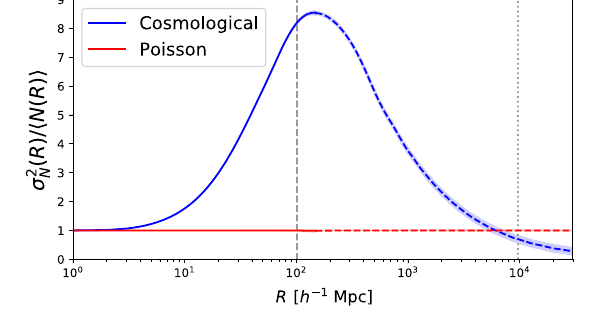
FIG. 4. Local number variance for the cosmological (blue) and Poisson (red) simulations as a function of scale R . This is defined as the variance of the number of particles found in spheres of radius R and computed directly from the correlation function shown in Fig. 3. The dashed lines show an extrapolation to large R , using the theoretical asymptotic structure factor form [with S ð k Þ ∼ k 0 . 96 ]. The vertical lines show two characteristic scales: the sound horizon at recombination (dashed), which sources acoustic wave in the early Universe, giving the bump in h ð r Þ , and the size of the Universe as it transitioned from radiation to matter dominated